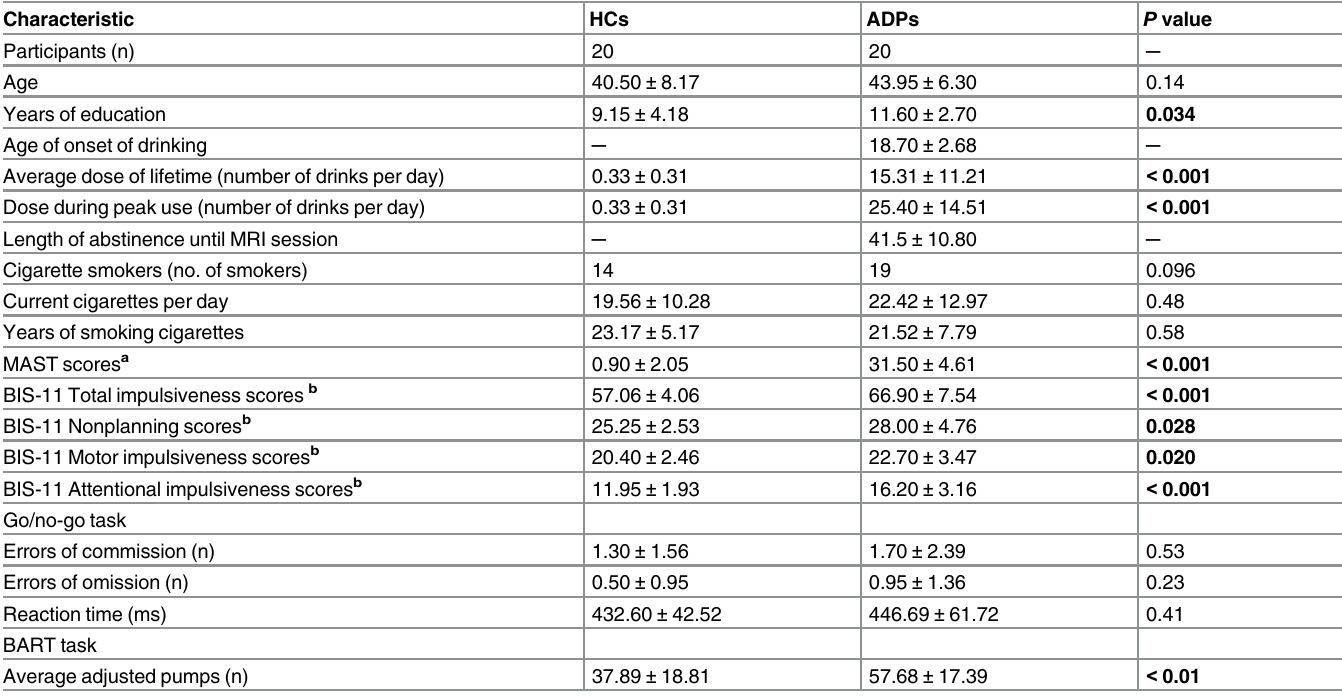
Table 1. Demographic, behavioral data and clinical characteristics of